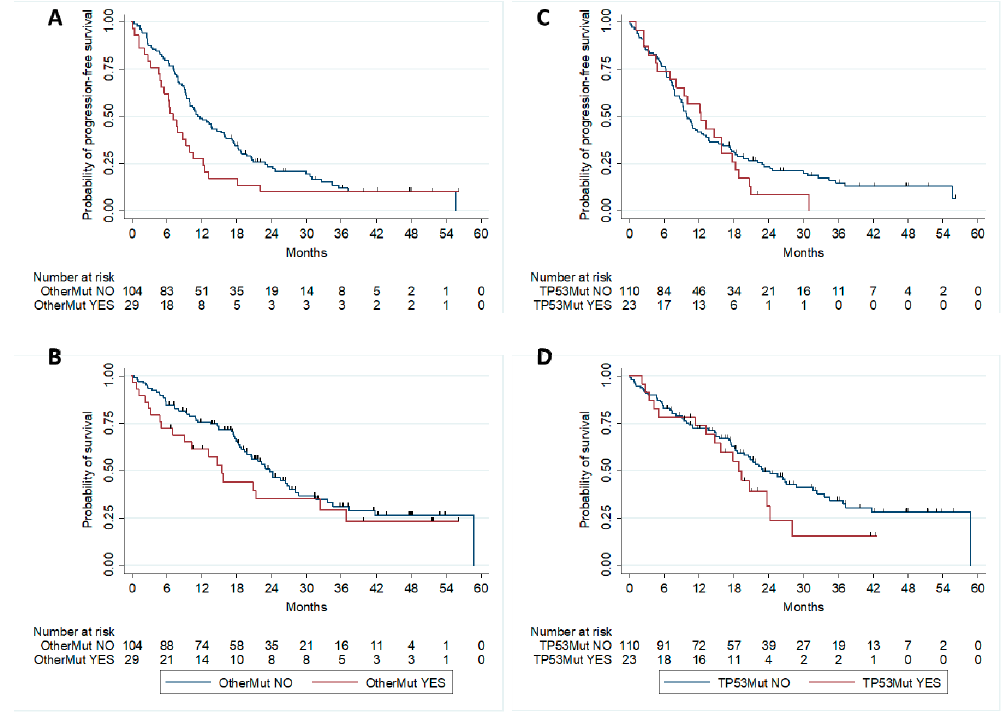
Figure 2. PFS ( A ) and OS ( B ) of EGFR-mutant patients with and without “other mutations”; PFS ( C ) and OS ( D ) of EGFR mutant patients with and without TP53 mutations.